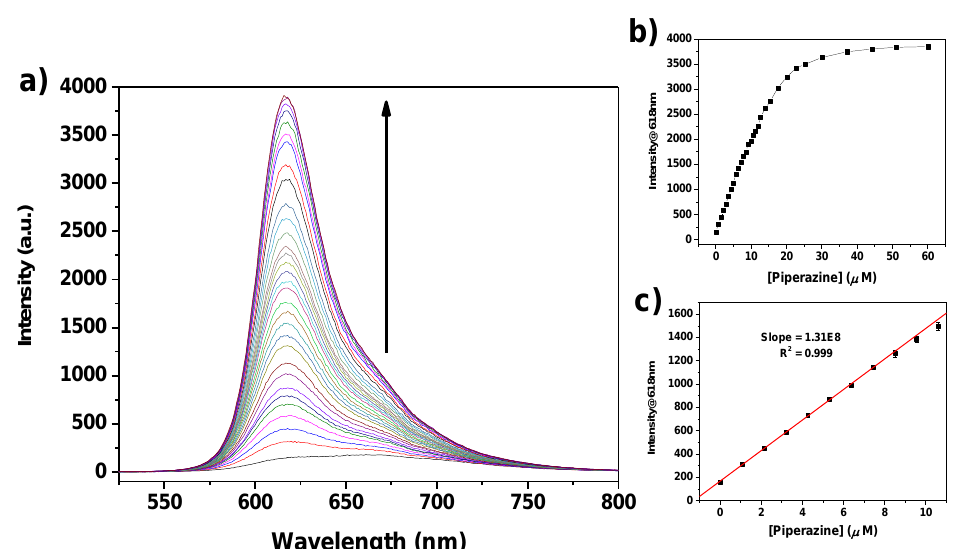
Figure 7. ( a ) Fluorescence titration curves of 1 (15 µ M solution in CHCl 3 ; λ exc = 515 nm) with addition of PZ. The concentration of PZ added varied from 0 to 60 µ M. ( b ) Variation of the fluorescence intensity at 618 nm as a function of the concentration of PZ added. ( c ) Linear best fit in the linear dynamic range (weight given by data error bars). The selectivity of 1 towards PZ was proven by performing competitive experiments.